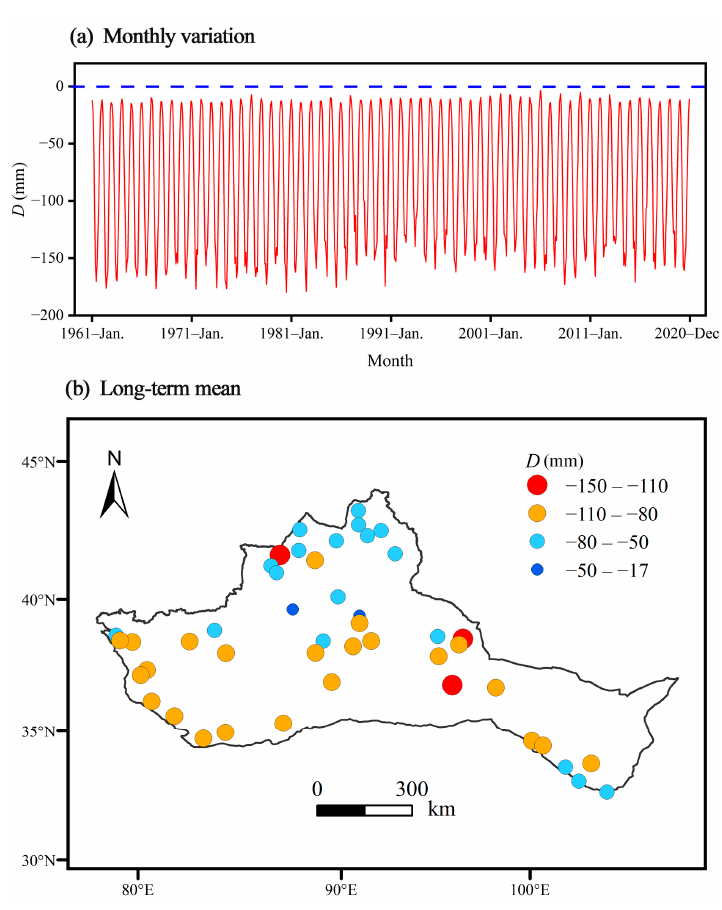
Figure 3. The temporal and spatial variation of D in northwestern China. (confirm)